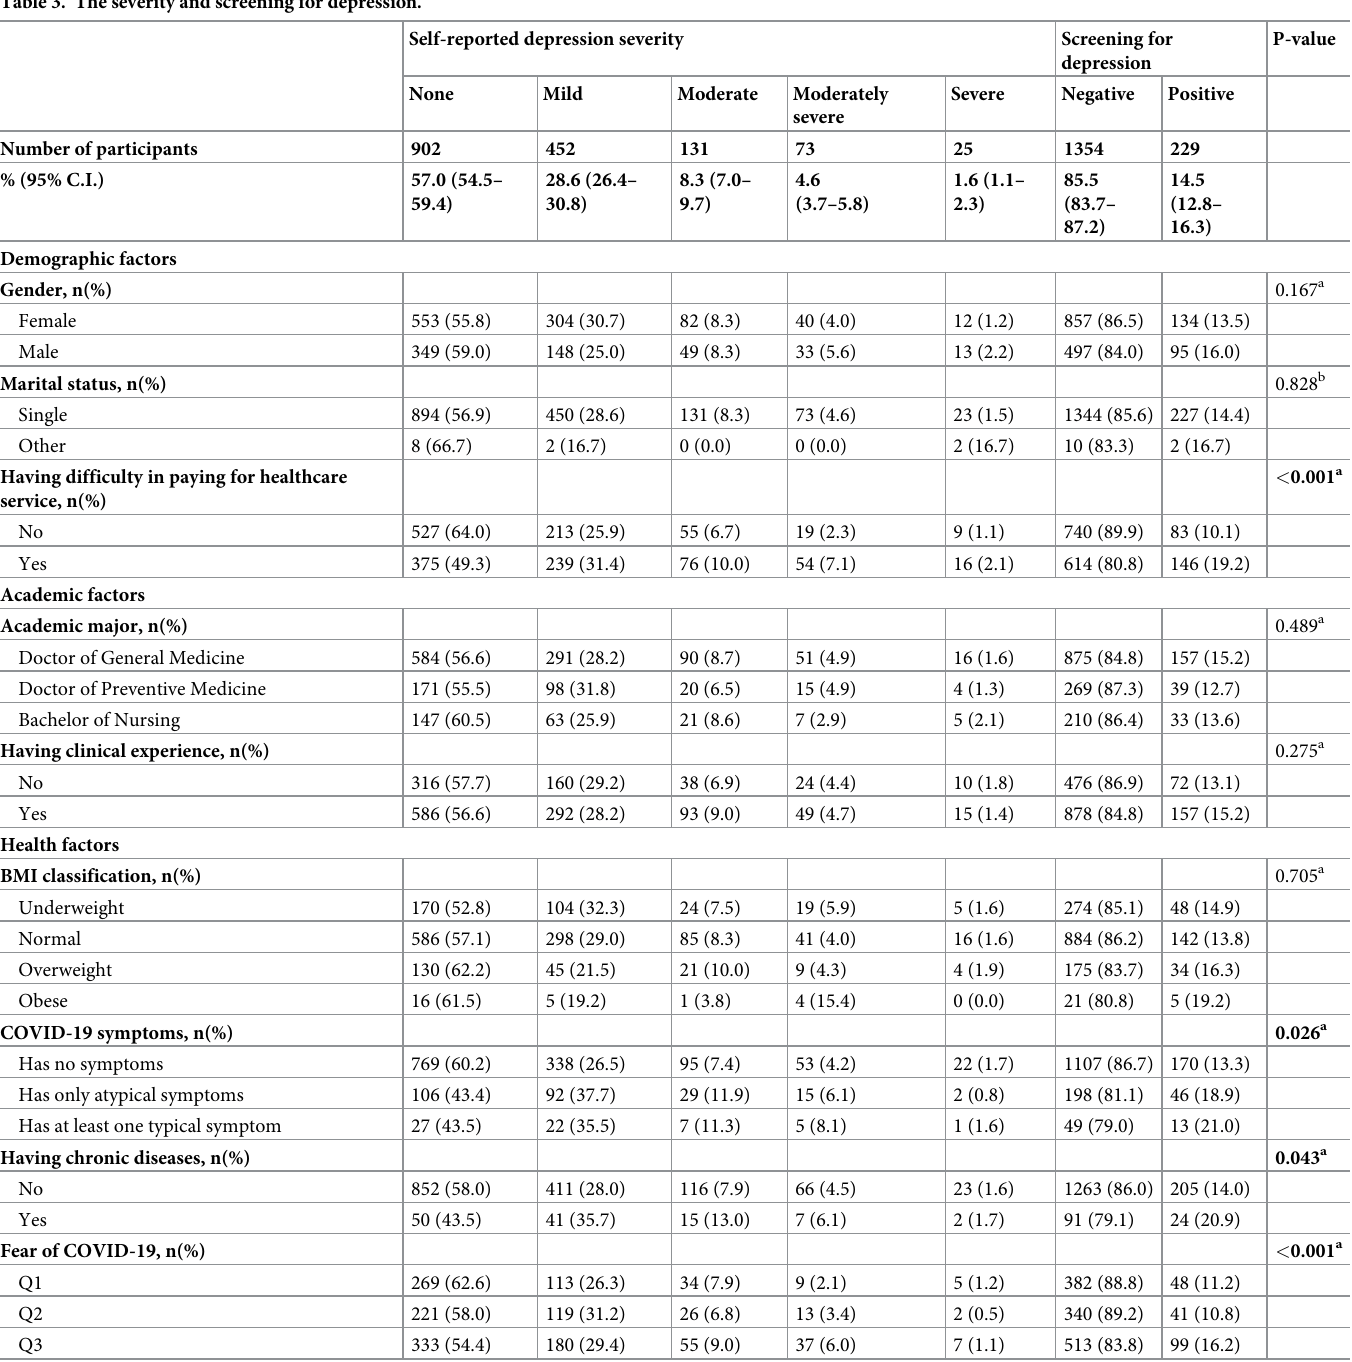
Table 3. The severity and screening for